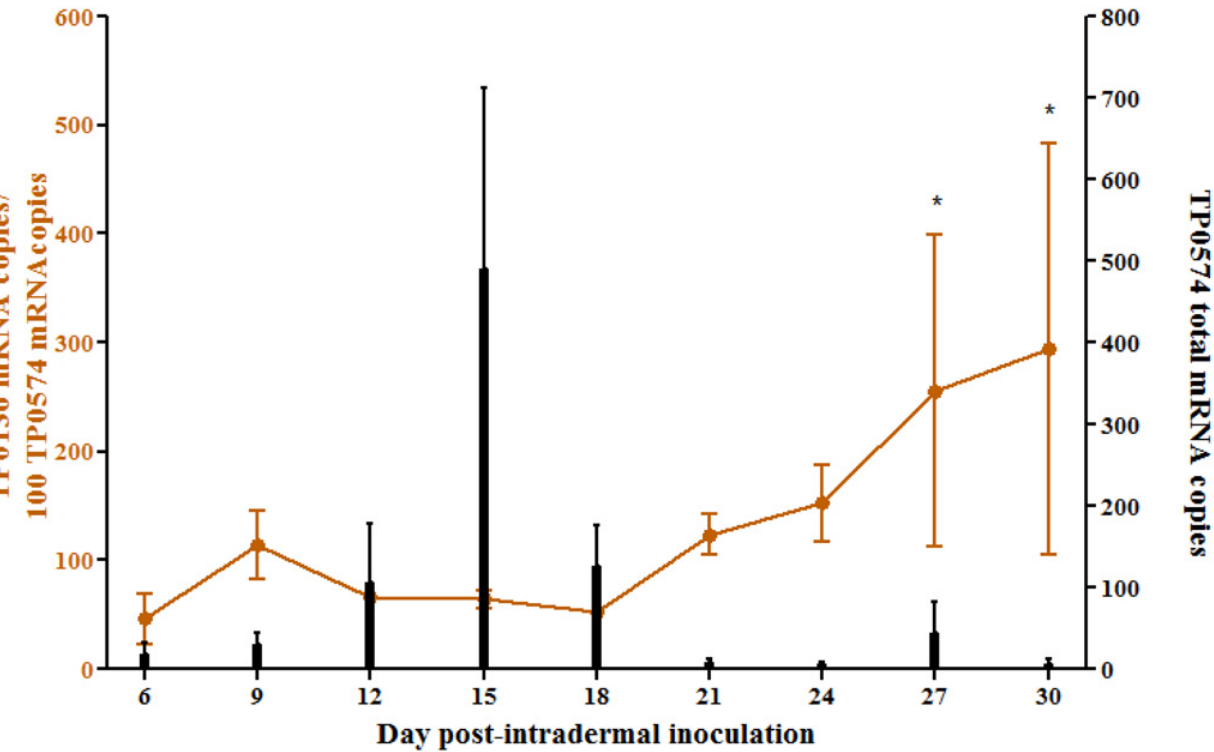
Fig 2. TP0136 message quantification during experimental infection. For message quantification, a biopsy from the leading edge of a dermal lesion was obtained from each of the three infected rabbits every three days for 30 days. Each sample was amplified in triplicate. The data were reported as the mean values ± standard error (SE) for triplicate experiments. Left y axis shows real-time qPCR analysis of TP0136 message normalized to TP0547 mRNA (orange line) during progression of primary syphilitic lesions in the rabbit model. Although biopsies were obtained at day 0 and day 3 as well, no message quantification was possible from these samples. Newman-Keuls Multiple Comparison Test was used to assess significant differences in TP0136 message level between time points ( * p < 0.05) whenever a significant difference between sample means was found by ANOVA. Right y axis shows absolute quantification data for TP0574 message (black bars), reflecting absolute T . pallidum